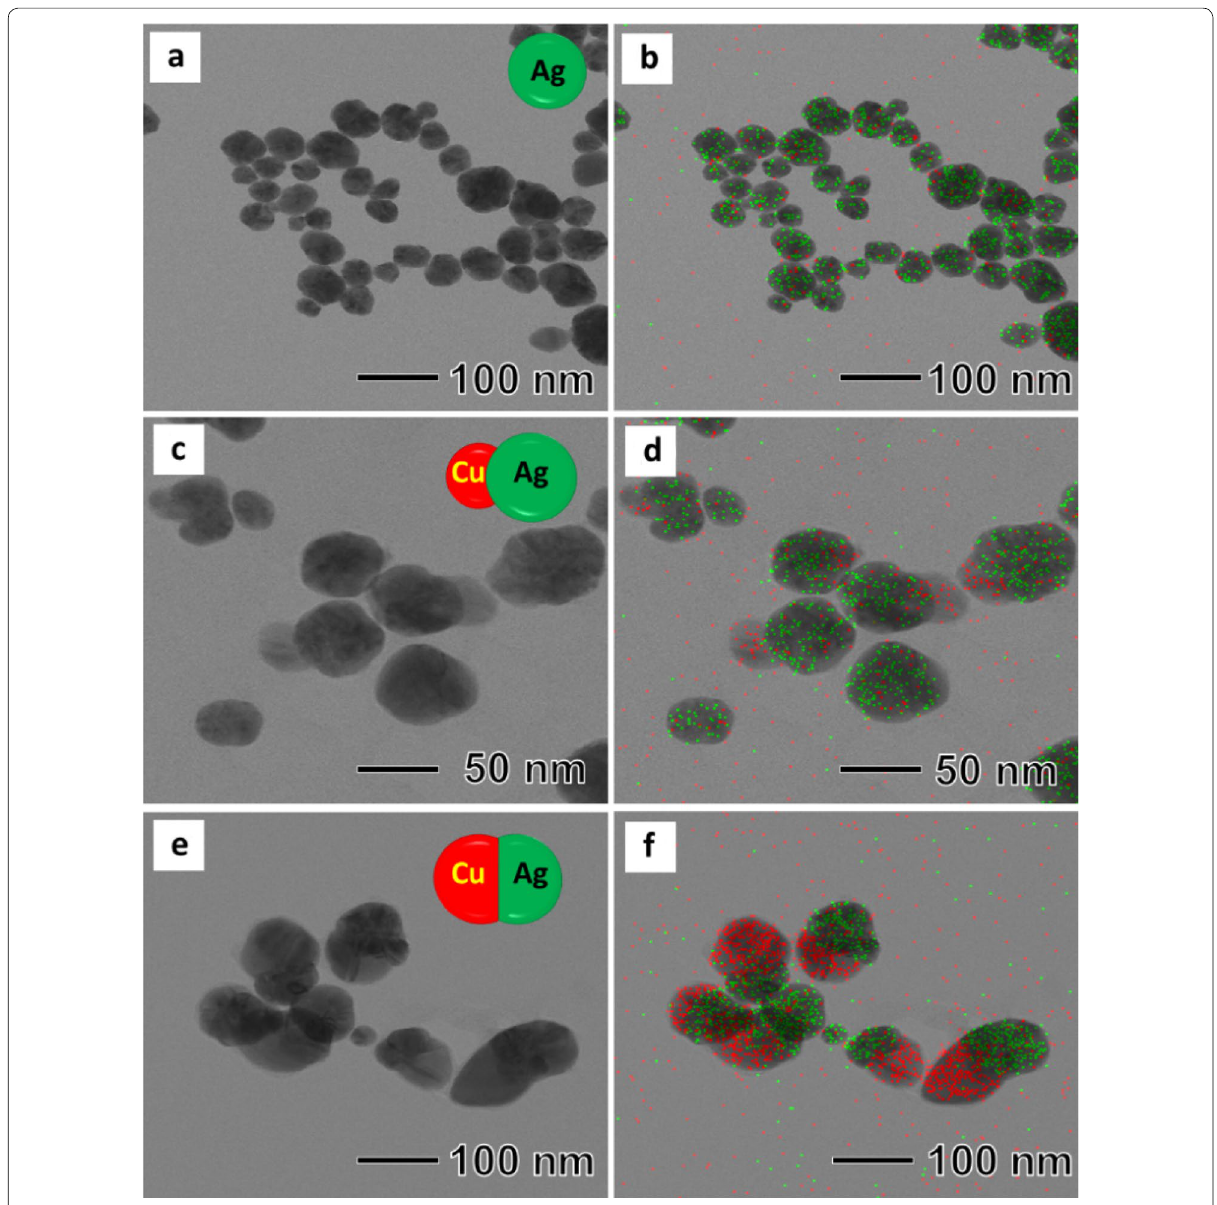
Fig. 3 TEM images and EDS images of products obtained at different reaction time ( a ) and ( b ) 5 s, ( c ) and ( d ) 30 s, ( e ) and ( f ) 150